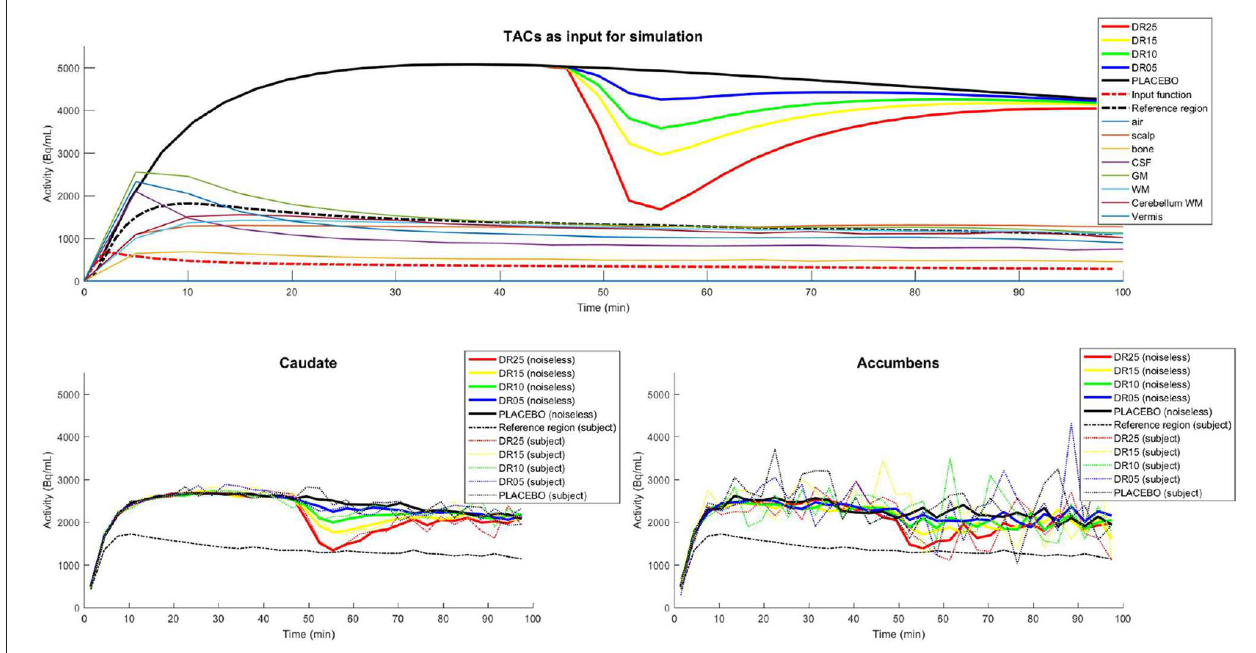
FIGURE 3 | (Top) Ideal TACs used as input for the PET-SORTEO simulations. The three regions caudate, putamen, and accumbens nuclei share the same TACs. TACs corresponding to endogenous releases of dopamine of 0, 5, 10, 15, and 25%, (PLACEBO, DR05, DR10, DR15, and DR25) were used successively for the simulation of the left caudate, putamen, and accumbens nucleus. (Bottom) Caudate (left) and Accumbens (right) TACs measured from the images reconstructed from the simulated data: Mean of the measured TACs (noiseless TACs) over all subjects (solid line) and measured TACs from a single subject (dashed line). The TAC of the reference region is shown for the subject in the PLACEBO condition. Note that the magnitude of the TACs are not completely retrieved in the reconstructed images due to signal degradation caused by the limited spatial resolution of the system (partial volume effects). The accumbens is a smaller region than the caudate, which explains the higher level of noise in the